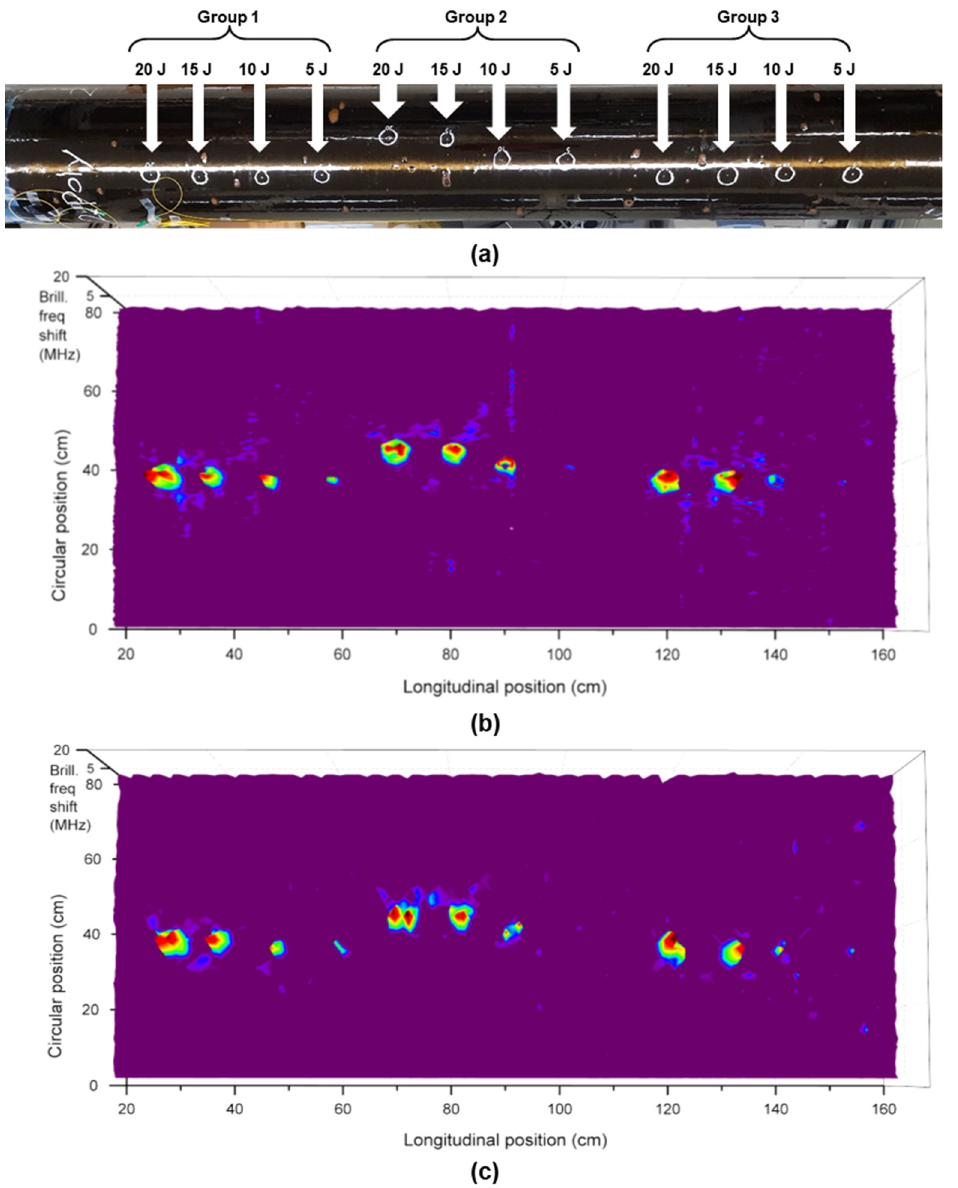
Figure 6. ( a ) Photo of the cylinder marked with white circles for impact points, and the damage maps with ( b ) 16 Gbps measurement and ( c ) 5 Gbps measurement.